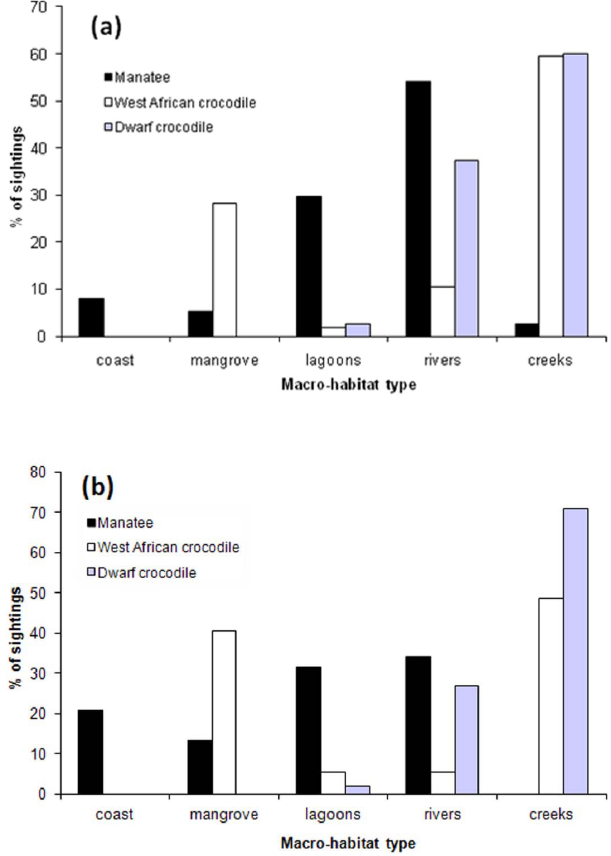
Figure 3. Percent of records of manatees and crocodiles by macro- habitat type in southern Nigeria during the wet season (a) and the dry season (b) .